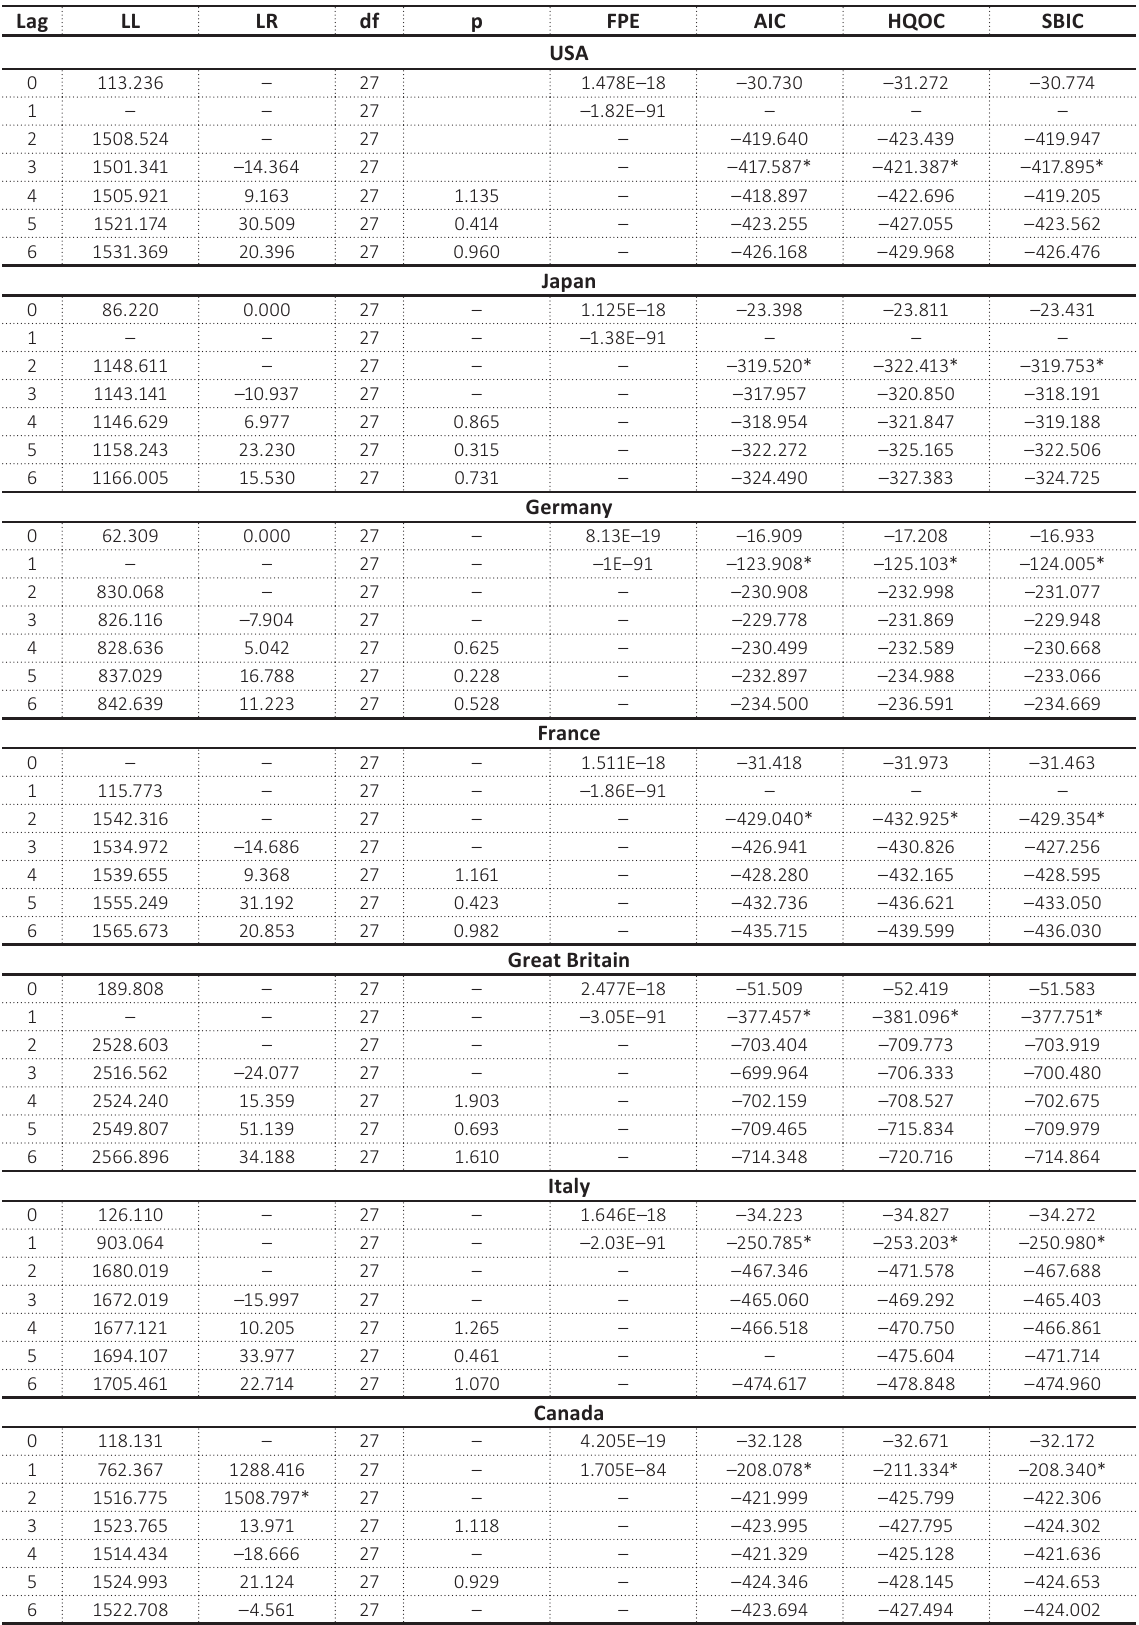
Table 7. The maximum lag of the influence of accounting information transparency on business